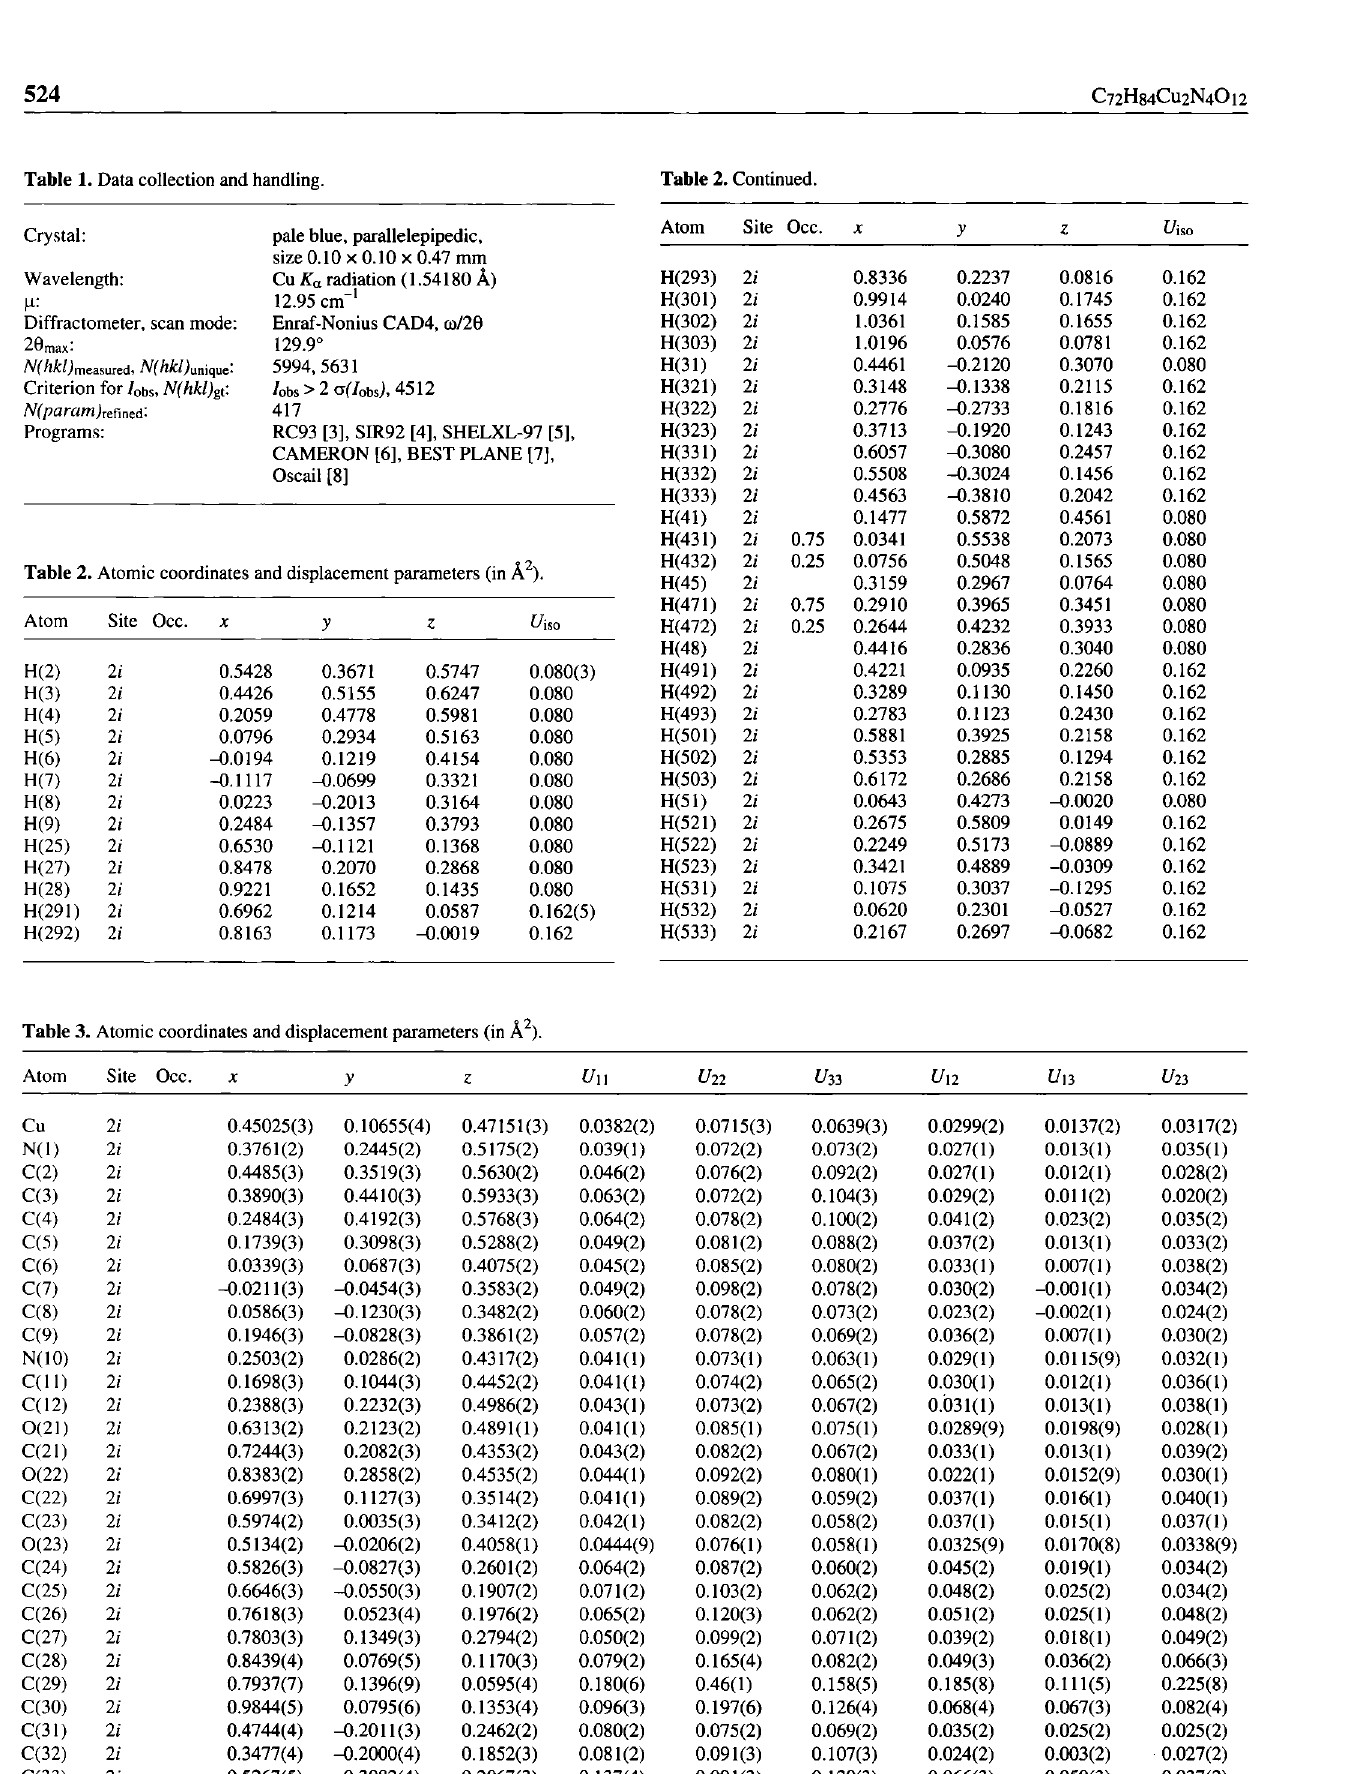
Table 3. Atomic coordinates and displacement parameters (in Â 2